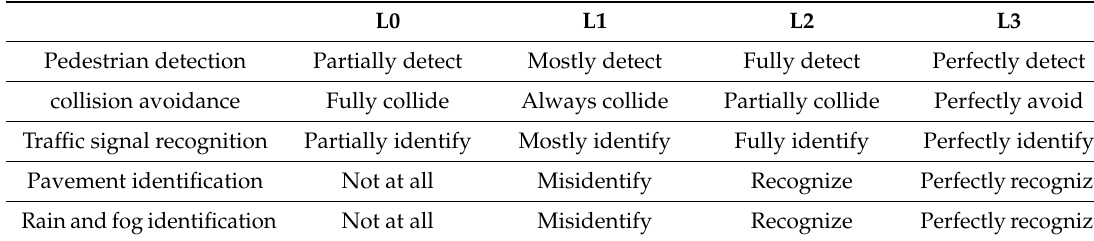
Table 3. Evaluation metrics of unmanned